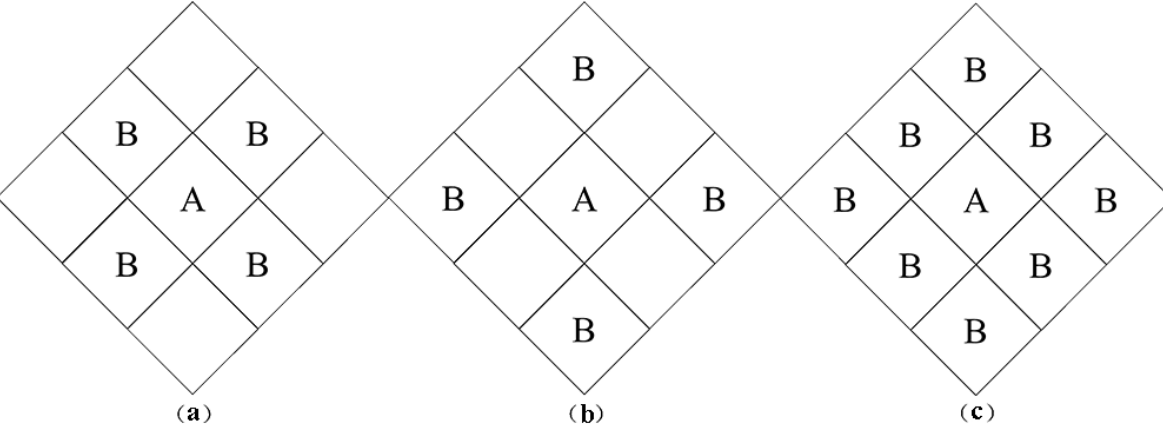
Figure 1. Different types of spatial contiguity matrices. *(a) Rook adjacency; (b) Bishop adjacency; (c) Queen adjacency.